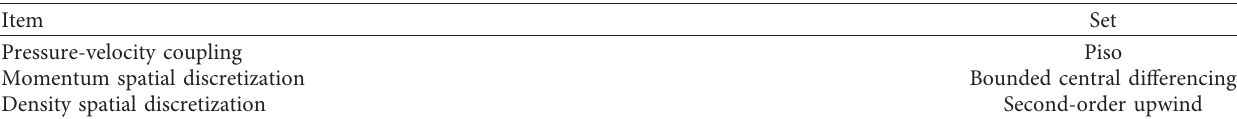
Table 4: Set of the transient parameter.